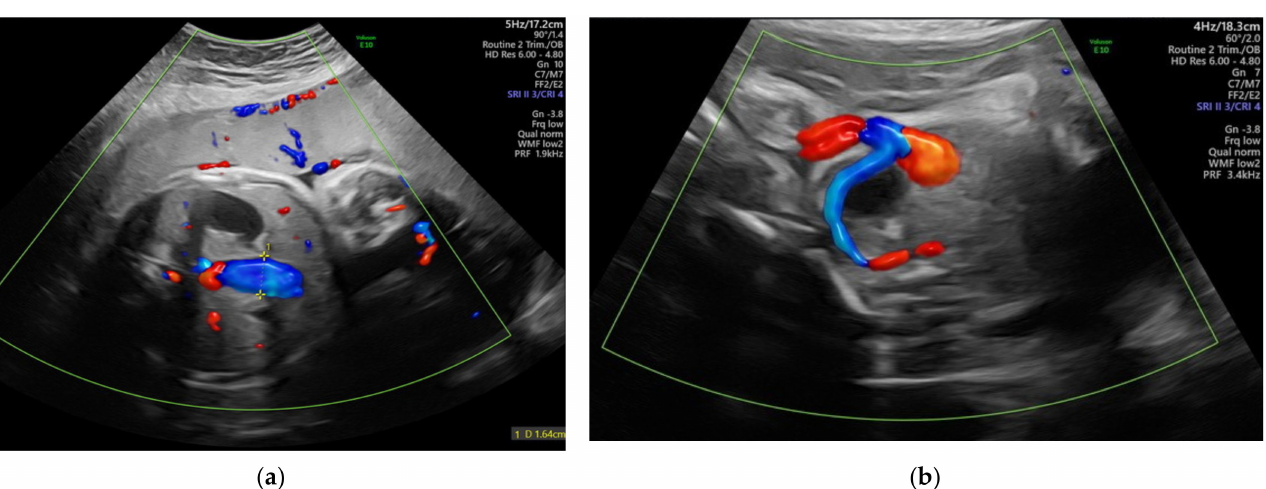
Figure 11. Two dimensional color-Doppler of umbilical vein varix typically occurring in the intraab- dominal portion of the vein. ( a ) transverse abdominal section and ( b ) oblique vesical section.